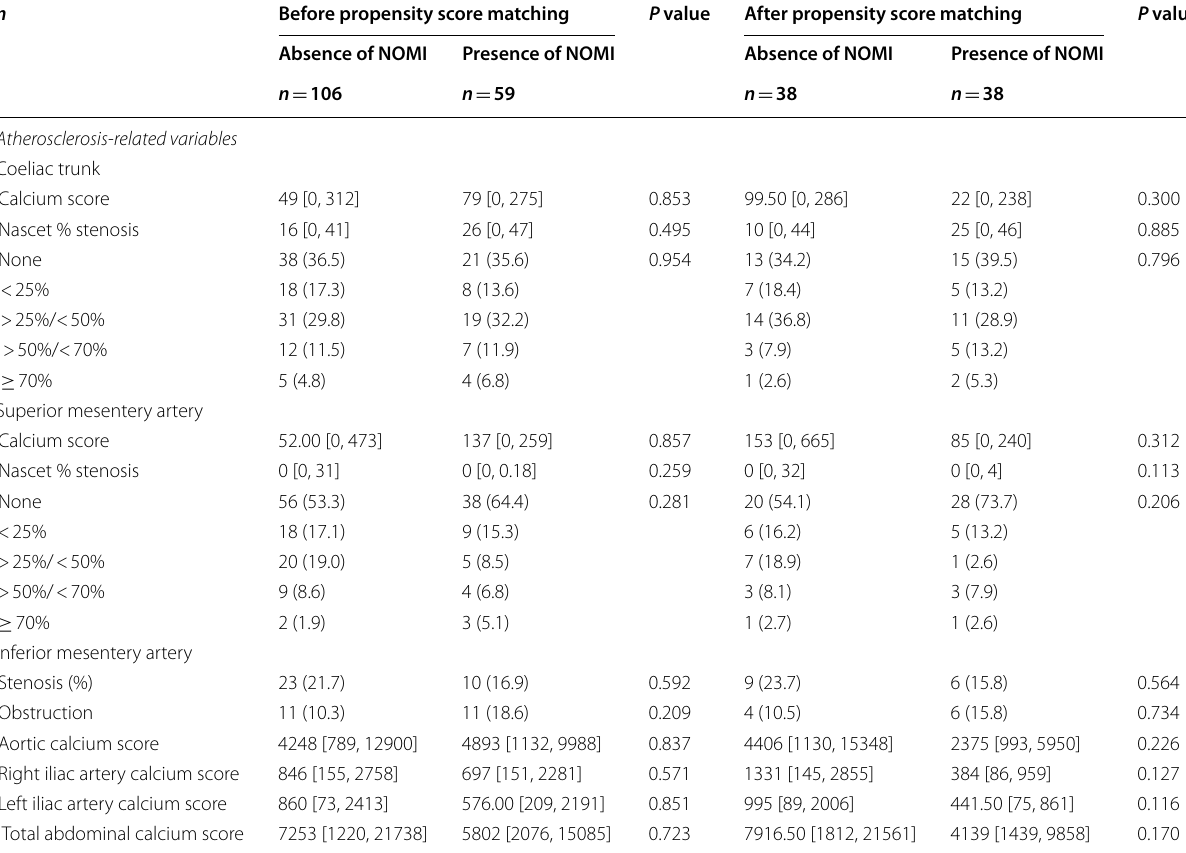
Table 4 Atherosclerosis-related CT variables before and after propensity score